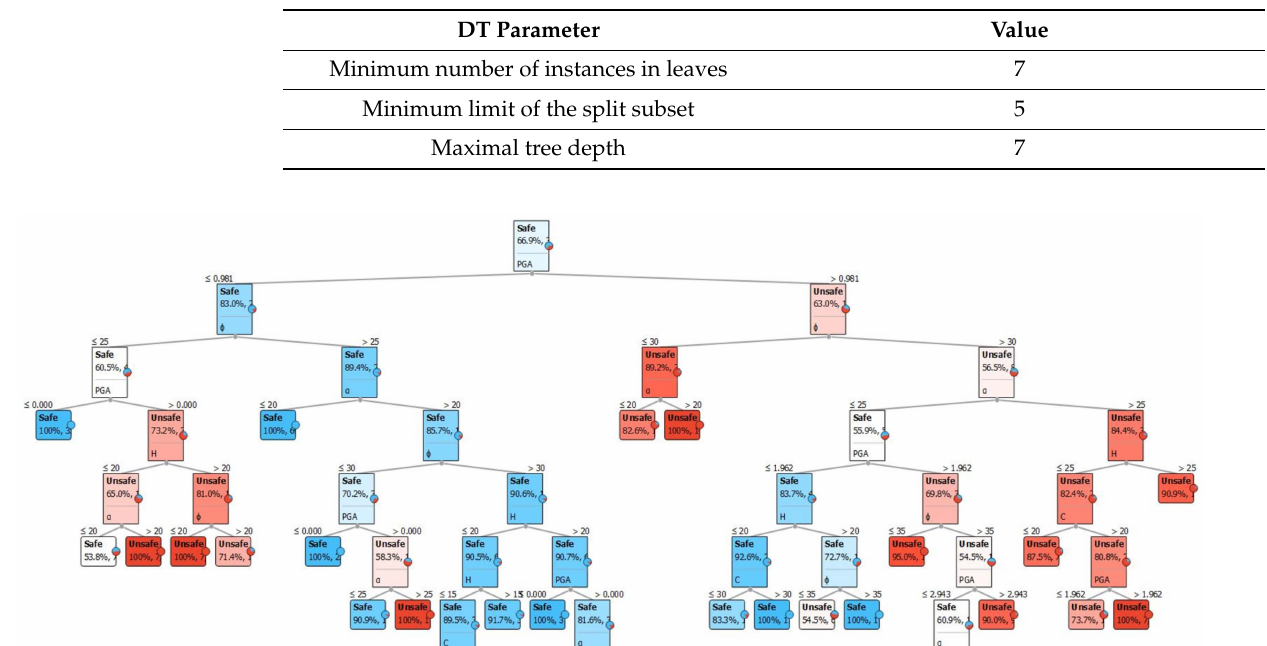
Table 4. The optimal parameters obtained by the DT model.